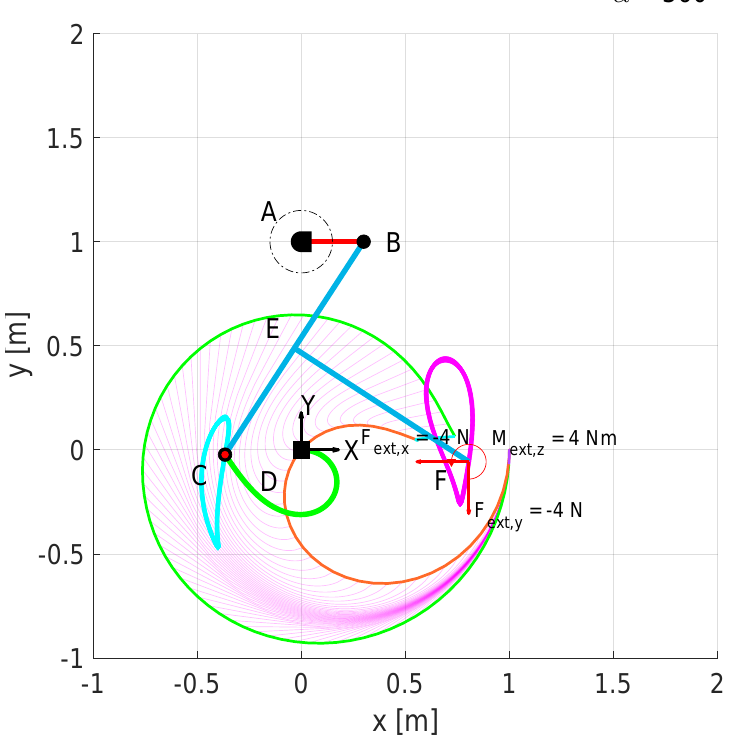
Figure 22. Third mechanism circuit under external loading of F ext , x = − 4 N, F ext , y = − 4 N, and M ext , z = 4 Nm. Final position and